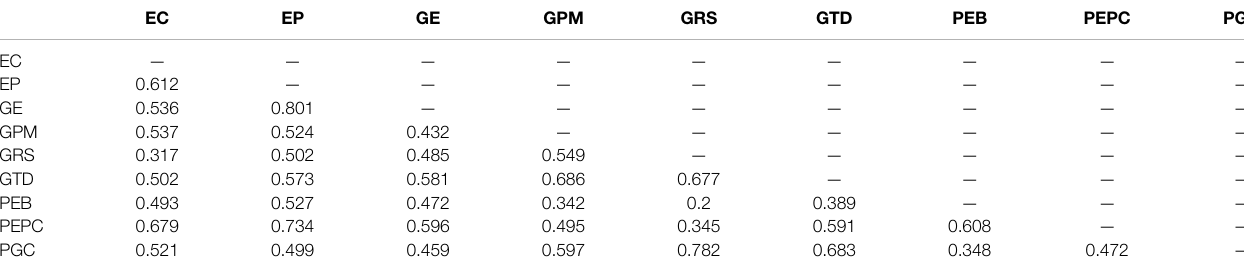
TABLE 2 | Discriminant validity (HTMT ratio) EC